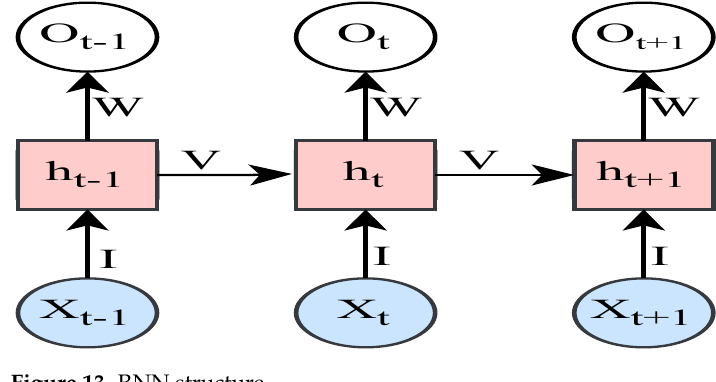
Figure 13. RNN structure.